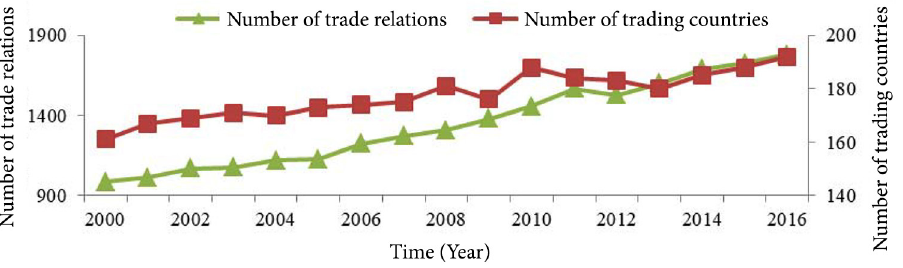
Figure 4. Trends in the total international trade of potassium